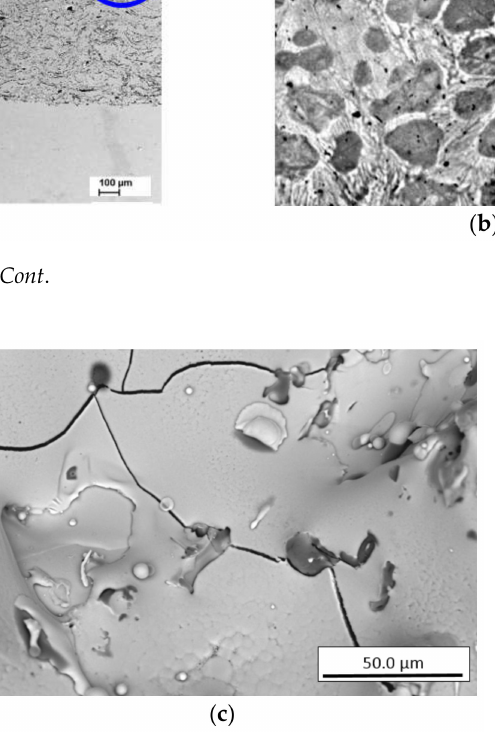
Figure 12. The microstructure of the coating in its cross section after heat treatment at 550 ◦ C at low ( a ) and high magnifications with precipitation of FeB and FeCrB borides as a dark inclusions in the coating structure ( b ) and microcracks between inclusions on the surface of the sprayed coating ( c ), due to which tensile stresses are relaxed in an arc coating obtained by spraying CW C1.4Cr14B3NiTi2Al. 1—coating and 2—steel